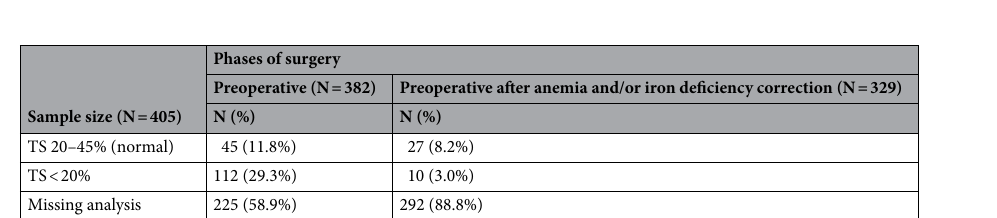
Table 4. Number of patients according the different values of transferrin saturation at preoperative period and after the treatment of anaemia/ iron deficiency correction.